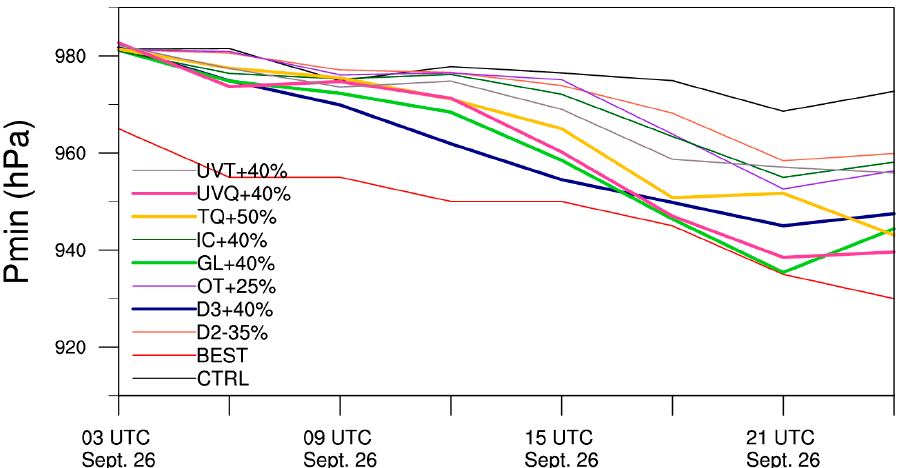
Figure 4. Simulated Pmin in the CTRL and predetermined eight ensemble forecast members. Thick contours indicate the members reproducing the RI.